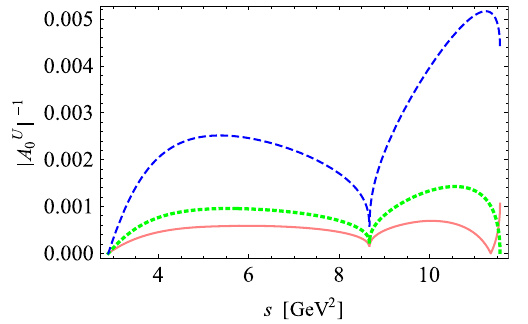
| − 1 as function of s for (cid:2) 0